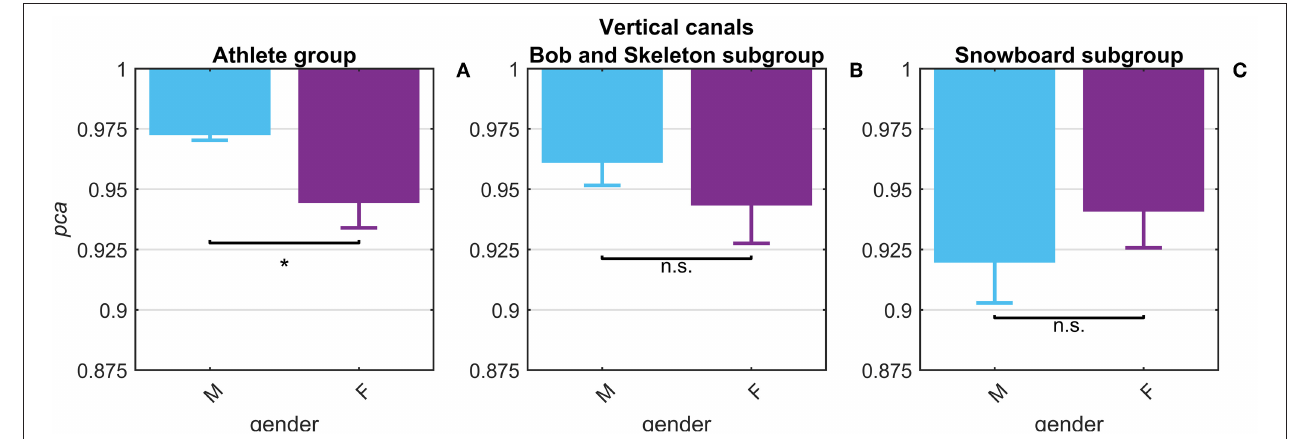
FIGURE 5 | Gender effect on proportion of correct answers ( pca ) for impulses in the plane of the vertical canals. Each bar represents the complement of pca ( i.e ., 1-pca) estimated in subgroups of athletes pooled by gender (female: violet bars; male: light blue bar). All pca were computed using the pooled approach (Equation 1) considering only head movements in the range of 2,001–6,000 deg/s 2 . Confidence intervals for pca were estimated as in Figure 3 . The asterisk (*) represents the statistically significant comparisons ( p -value < α = 0.05). Using the athlete group (A) , the pca estimated in the subgroups of female athlete was significant lower than the pca of male athlete. The effect of gender on fHIT performance, however, was not present considering also the sport factor (B,C) . The significant difference between genders, indeed, was induced by a non-uniform distribution of female athletes that were recruited only in the two sports (BS and SB) with the lowest pca for impulses performed in the vertical canals (see Table 2A